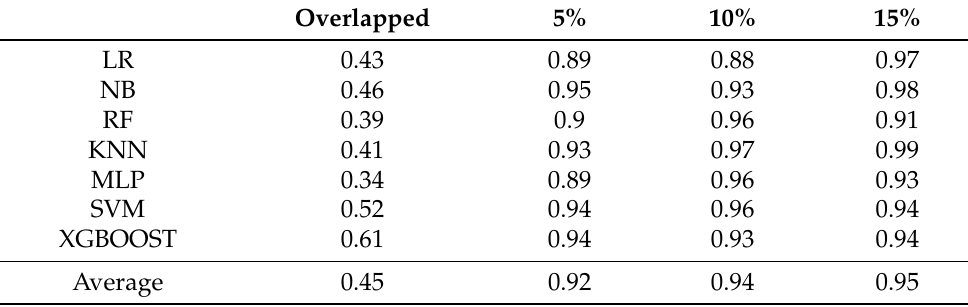
Table 2. Performance comparison of classifiers in terms of sensitivity.